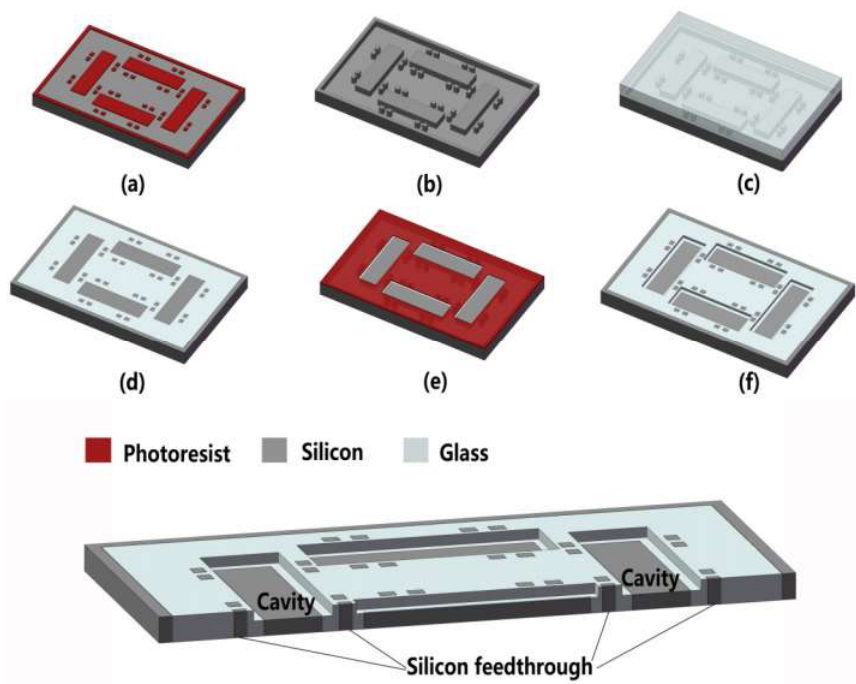
Figure 1. The fabrication flow of glass-silicon composite substrate: ( a ) photolithography for silicon mold; ( b ) silicon deep reactive ion etching; ( c ) anodic bonding between silicon and glass; ( d ) glass reflow and double-side chemical mechanical polishing (CMP) process; ( e ) the cavity defined by photoresist; ( f ) removal of the exposed silicon and glass. The bottom picture depicts a 3D sectional schematic of the glass-silicon composite substrate with the cavity.